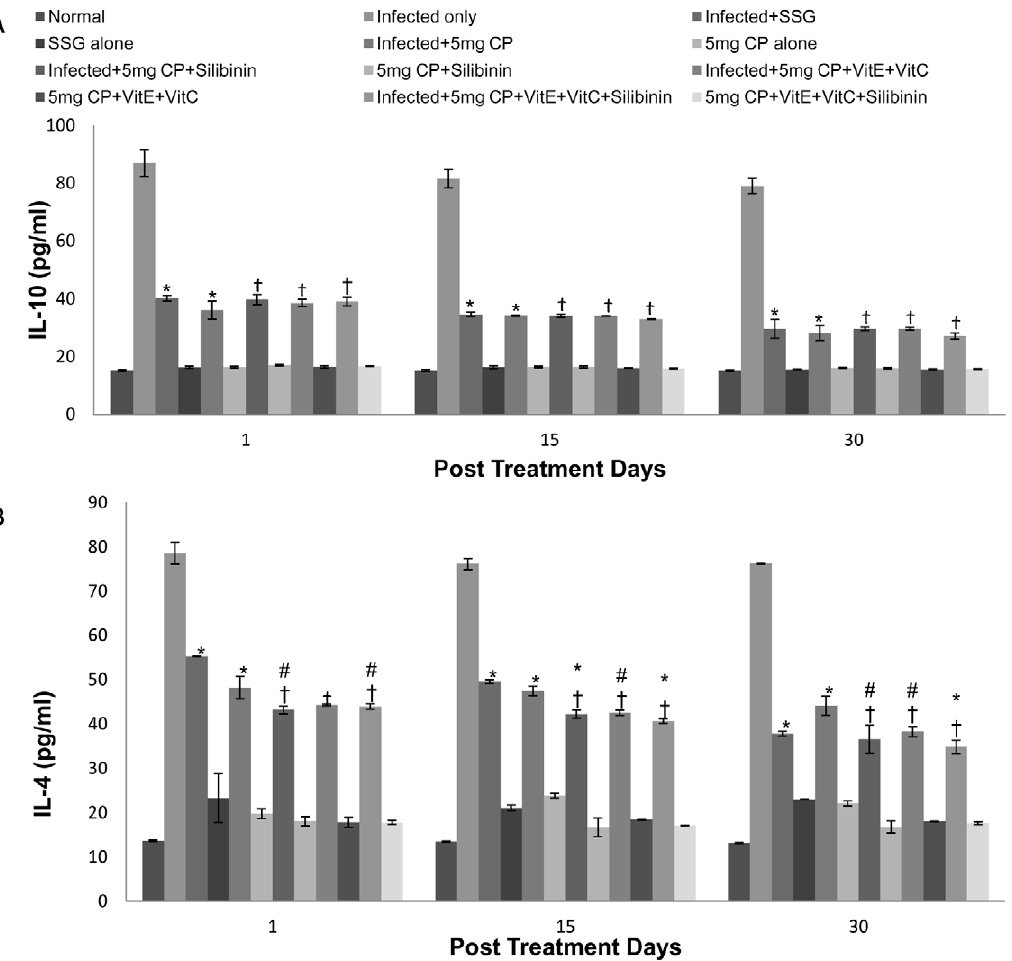
Figure 5. Cytokine levels in culture supernatants of spleen cells of different groups of animals. A- IL-10, B- IL-4. The data are presented as mean 6 S.D. of six mice per group. *, # -p value: Infected only vs Infected + SSG/Infected + 5 mg CP/Infected + 5 mg CP + Silibinin/Infected + 5 mg CP + VitE + VitC/Infected + 5 mg CP + VitE + VitC + Silibinin. { -p value: Infected + 5 mg CP vs. Infected + 5 mg CP + Silibinin/Infected + 5 mg CP + VitE + VitC/ Infected + 5 mg CP + VitE + VitC + Silibinin. *, { -p , 0.001; # -p ,